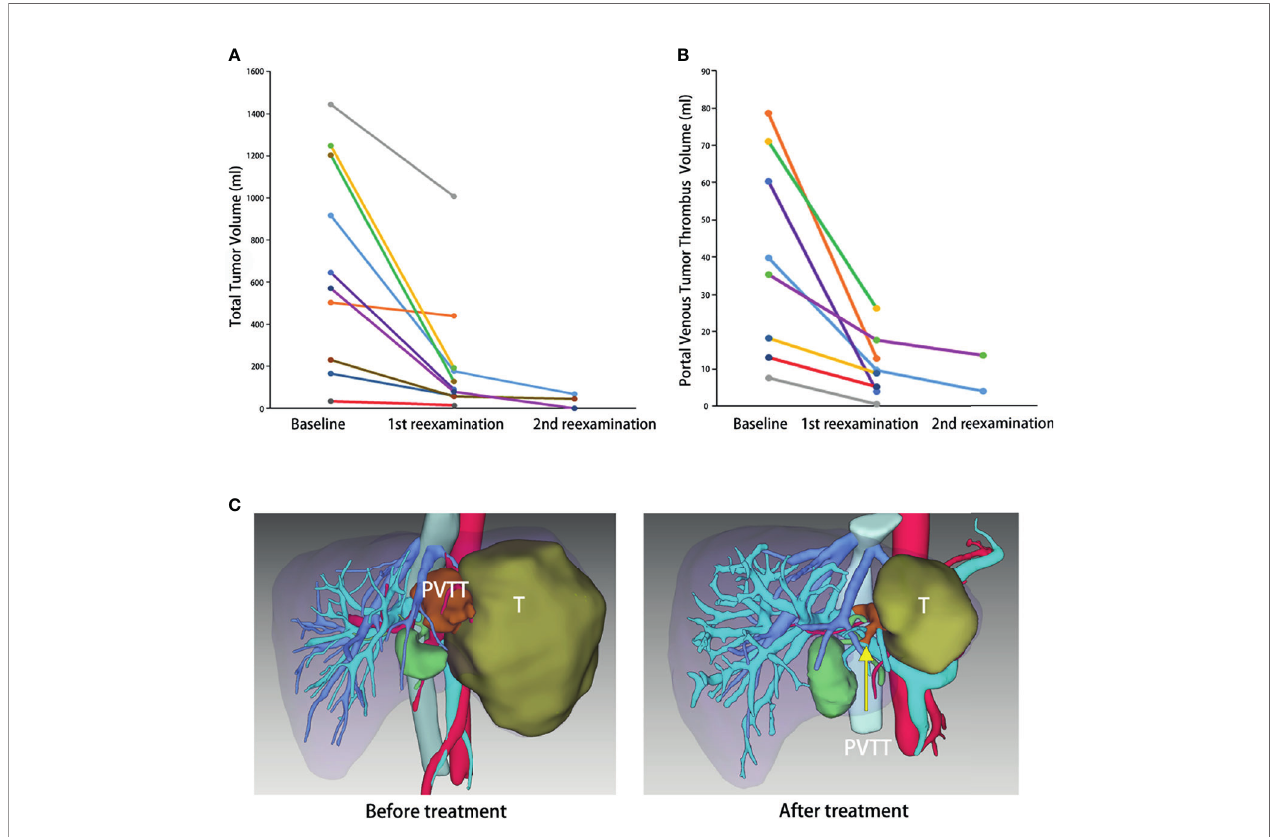
FIGURE 2 | The total tumor volume (TTV) and portal vein tumor thrombus volume (PVTTv) change demonstrated by 3D reconstruction. (A) Change in TTV over time by 3D reconstruction. (B) Change in PVTTv over time by 3D reconstruction. (C) Three-dimensional reconstruction of case no. 4 before and after the combination therapy. T , tumor. Yellow arrow :